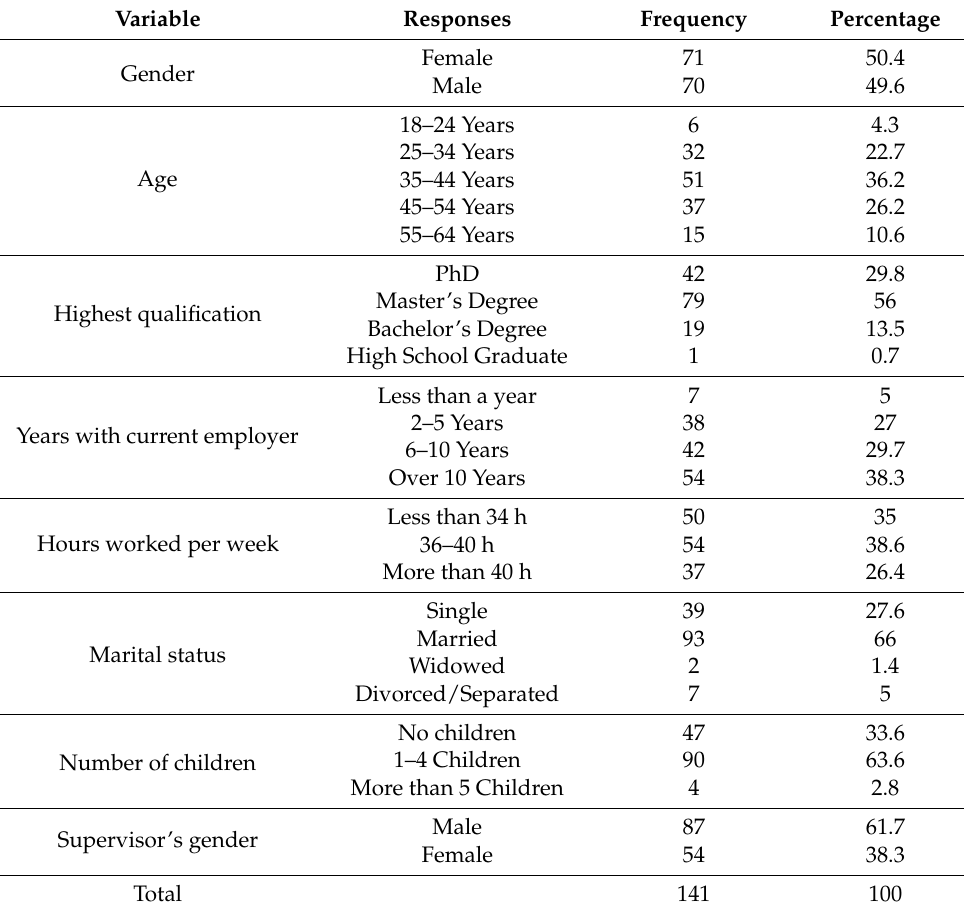
Table 1. Descriptive statistics of the sample ( N =